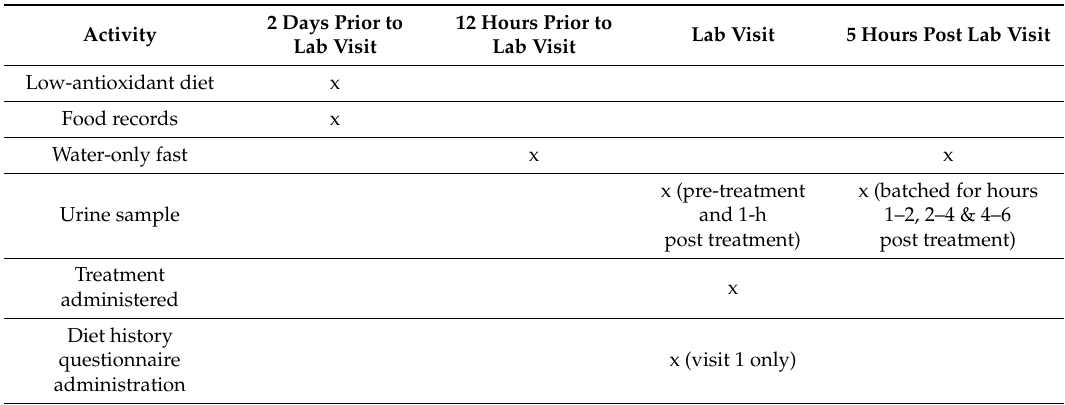
Table 1. Study schedule for one visit. Participants completed four visits, each separated by one